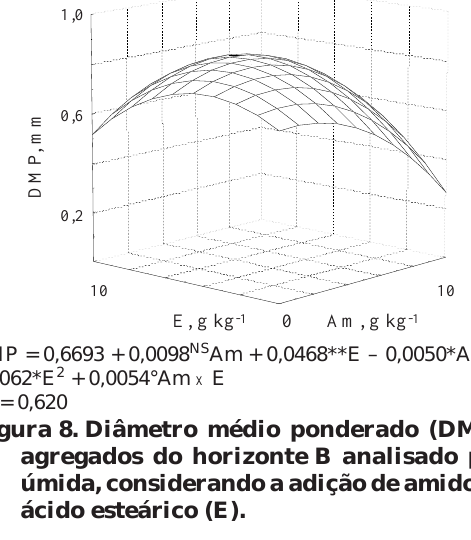
Figura 8. Diâmetro médio ponderado (DMP) dos agregados do horizonte B analisado por via úmida, considerando a adição de amido (Am) e ácido esteárico (E).